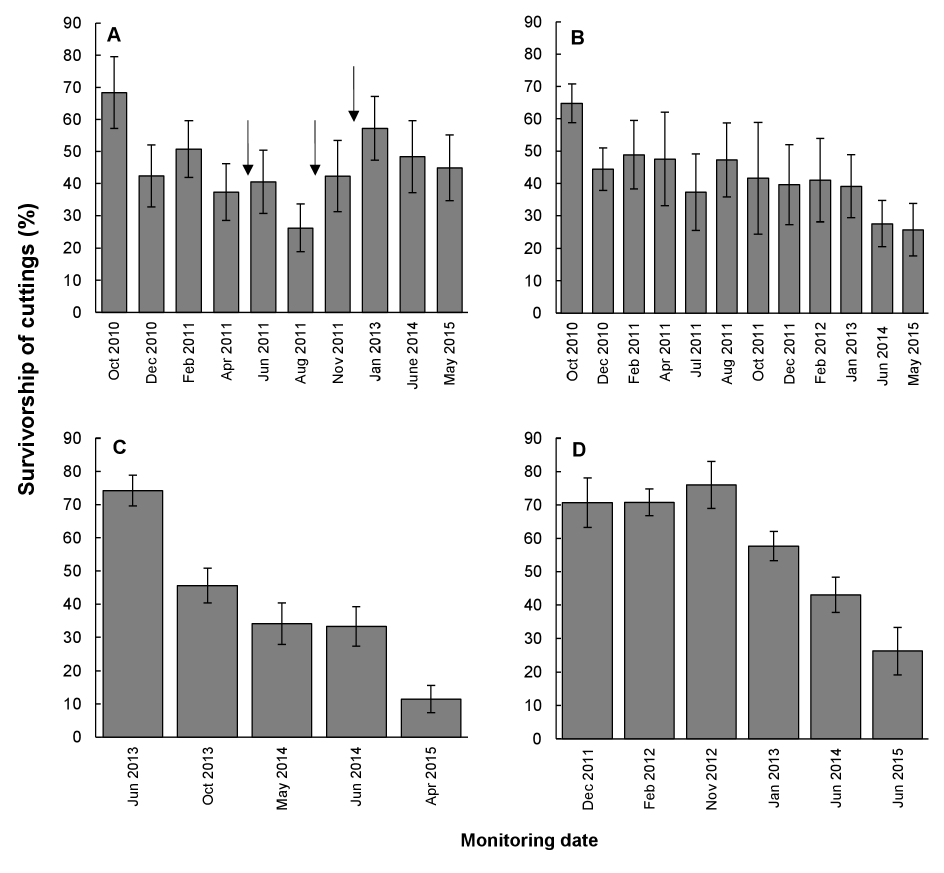
Figure 5. Percentage survivorship (± standard error) of spekboom cuttings (20 mm basal diameter at planting) planted at sites in the Eastern Cape, South Africa. ( A ) 50 hectare of plantings ~40 km SE of Steytlerville; ( B ) 50 hectare of plantings ~30 km NW of Jansenville; ( C ) 110 hectare of plantings ~65 km SE of Graaff-Reinet; ( D ) 104 hectare of plantings ~70 km W of Riebeek East. All sites were planted at an initial density of 2600 to 5000 cuttings per hectare. Data were recorded in 2015 from 10 m × 10 m plots and the number of plots sampled in each site varied from 5 to 15. Arrows indicate events of supplementary